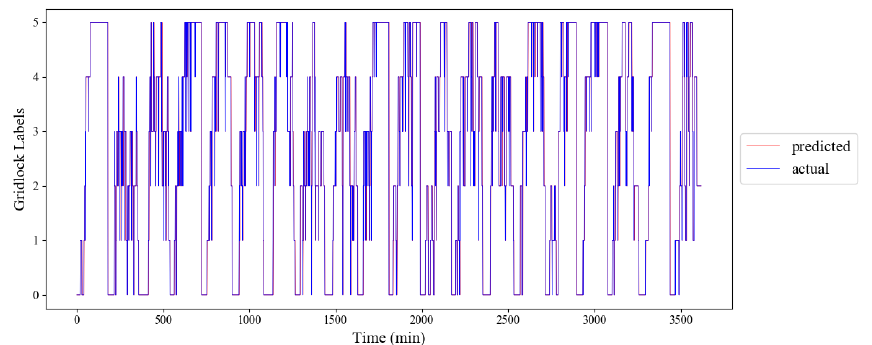
Figure 16. Example of actual and predicted gridlock labels with the 1 min time-lagged observation using the 5% sample size.